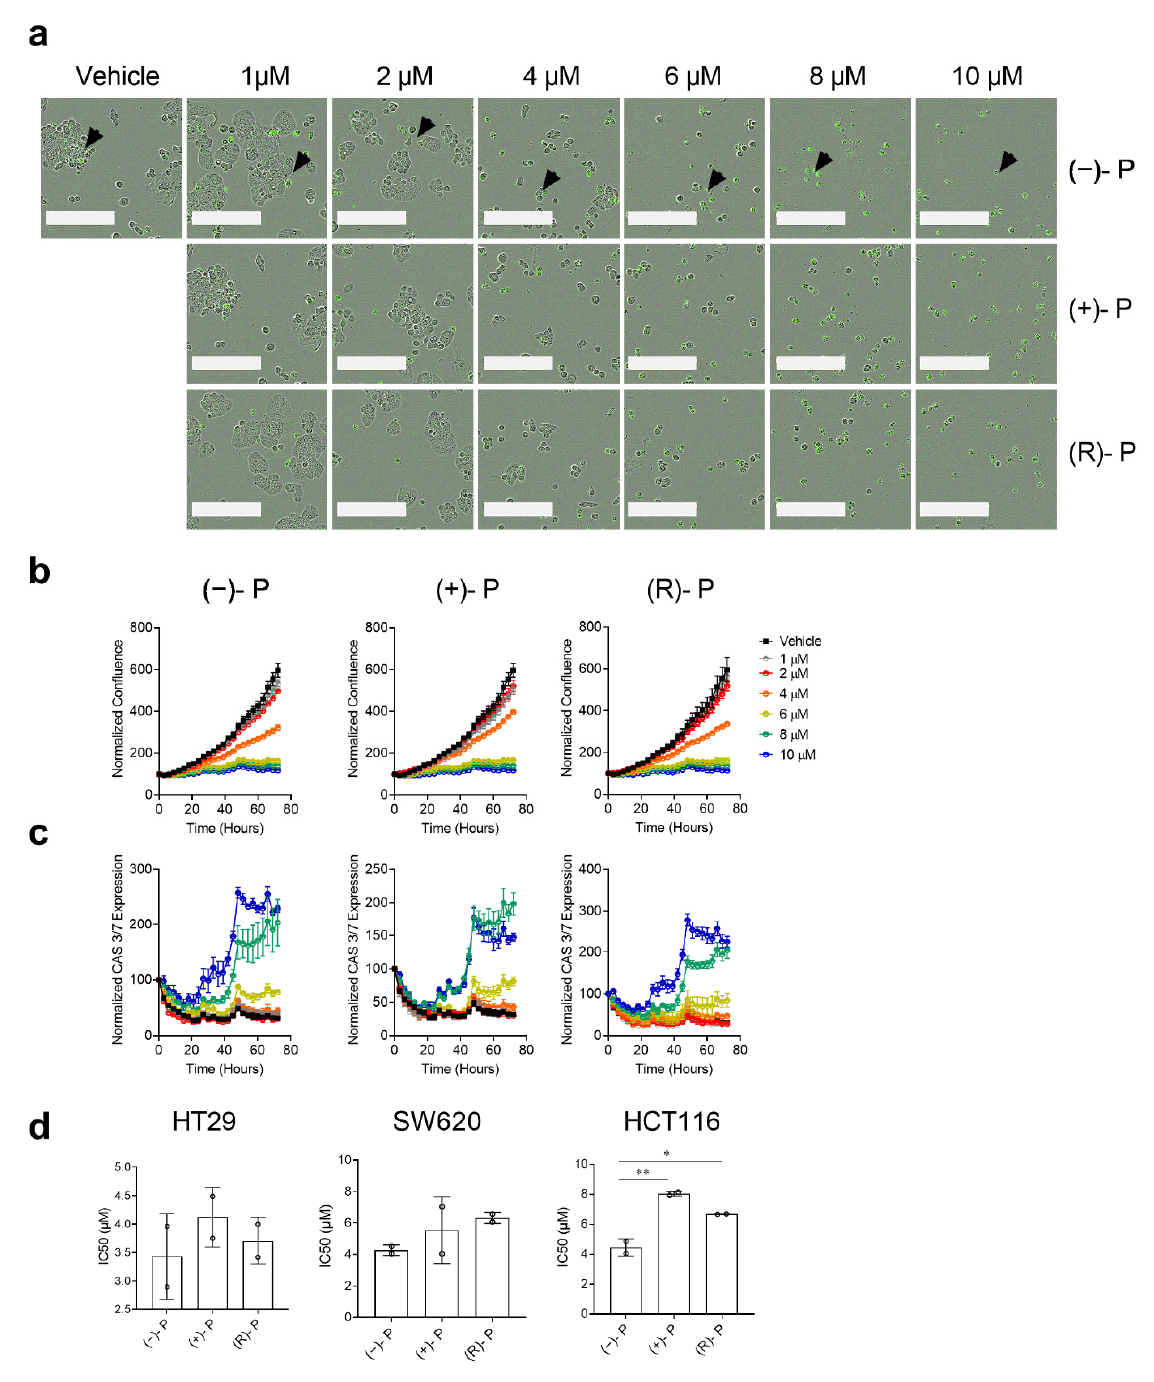
Figure 3. The kinetics of ( − )-P-, (+)-P- and (R)-P-mediated apoptosis of CRC cells grown in monolayers. CRC cells were monitored for 72 h in the presence of ( − )-P, (+)-P and (R)-P and Caspase-3/7 Green reagent using an Incucyte S3 Live Analysis System. ( a ) Representative images of HT29 cells 72 h post drug treatment. Caspase 3/7 positive cells are shown as green, indicated by the black arrows in ( − )-P. The white bar represents 200 µm. ( b ) Cell growth curves measured by calculating the confluence (%) from time 0. ( c ) Caspase 3/7 kinetics curves measured by calculating CAS 3/7+ (green) cells normalized to time 0. Individual points represent the mean ± SD from three technical replicates in a single experiment. Data are representative of two independent experiments. ( d ) The IC 50 values for the HT29, SW620 and HCT116 cell lines calculated and pooled from two independent experiments. Mean ± SD, * p ≤ 0.05, ** p ≤ 0.001. One-way ANOVA with a multiple comparisons test.